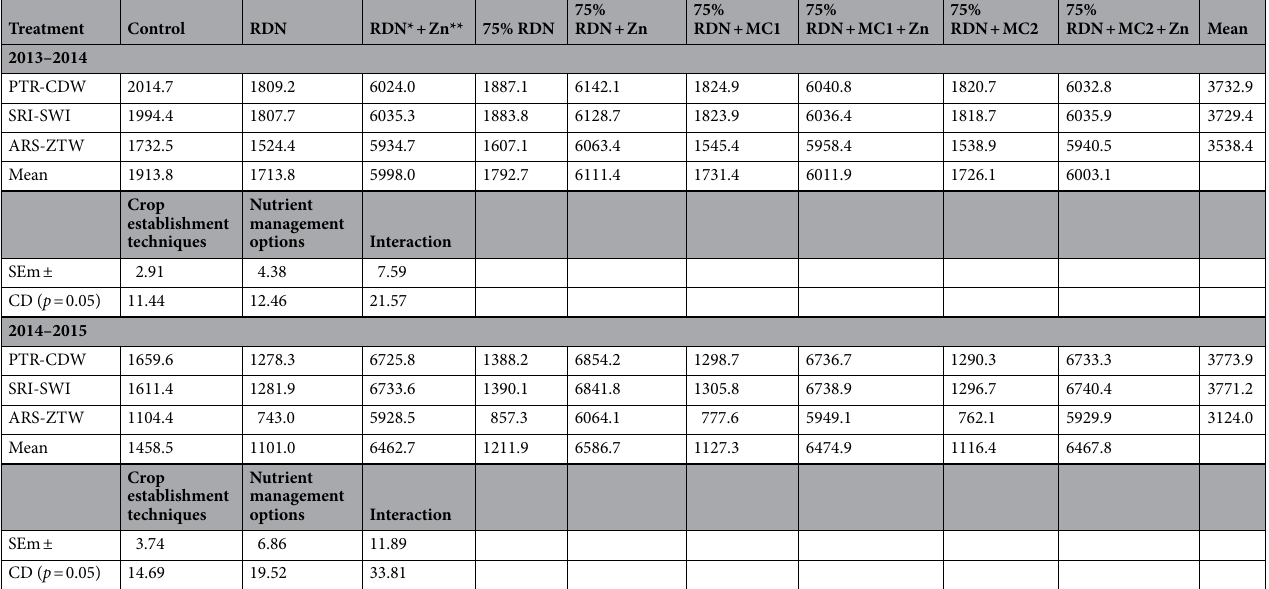
Table 9. Influence of crop establishment techniques and nutrient management options on soil DTPA- extractable Zn (g ha −1 ) after completion of first and second cycle of rice–wheat cropping system. PTR , puddled transplanted rice; SRI , system of rice intensification; ARS , aerobic rice system; CDW , conventional drill-sown wheat; SWI , system of wheat intensification; ZTW , zero tillage wheat; RDN* , recommended dose of